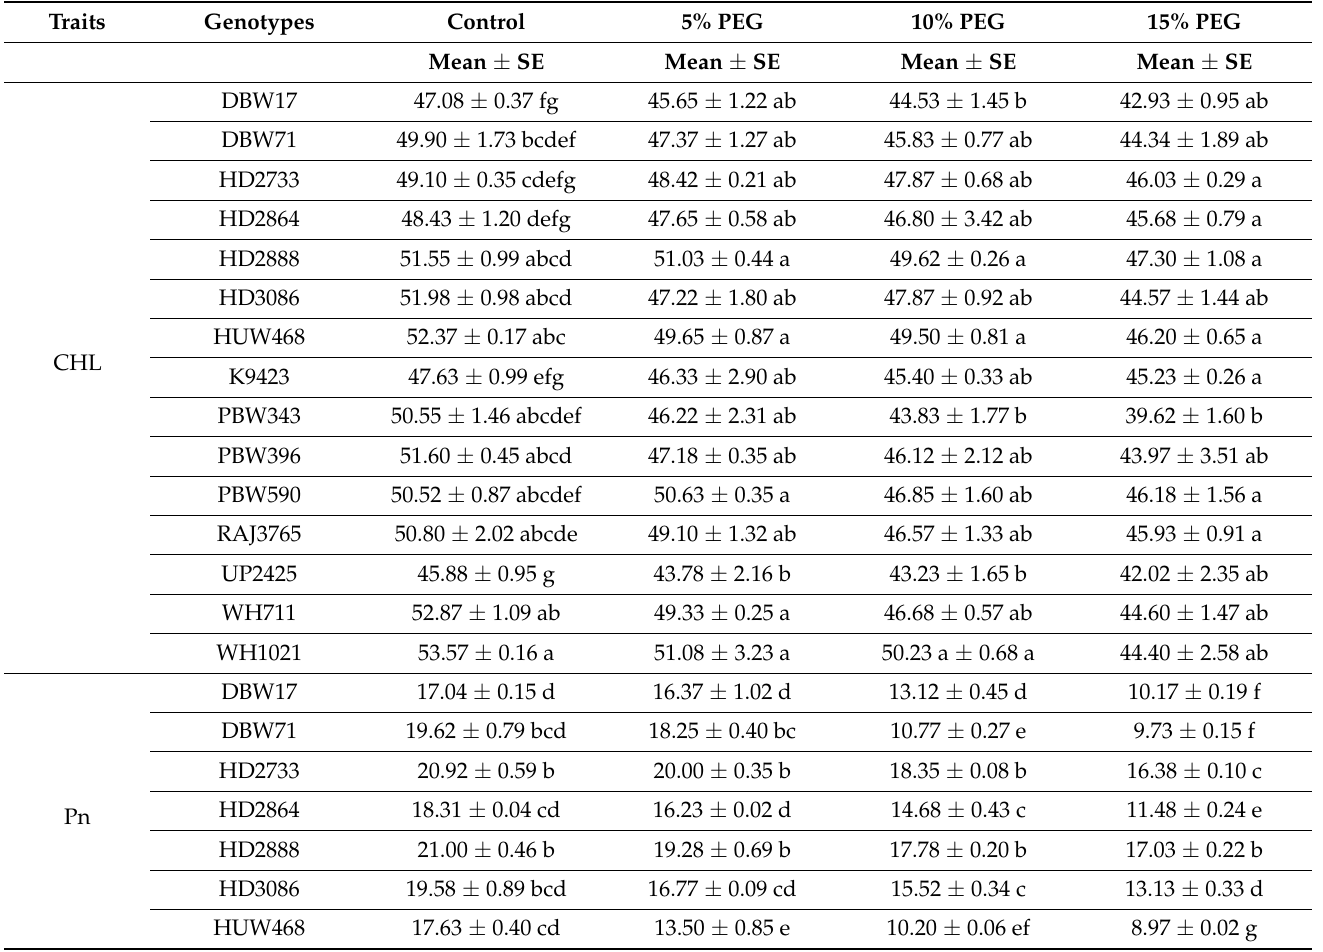
Table 4. Mean values of physiological and biochemical traits under control and 5%, 10% and 15% PEG treatment